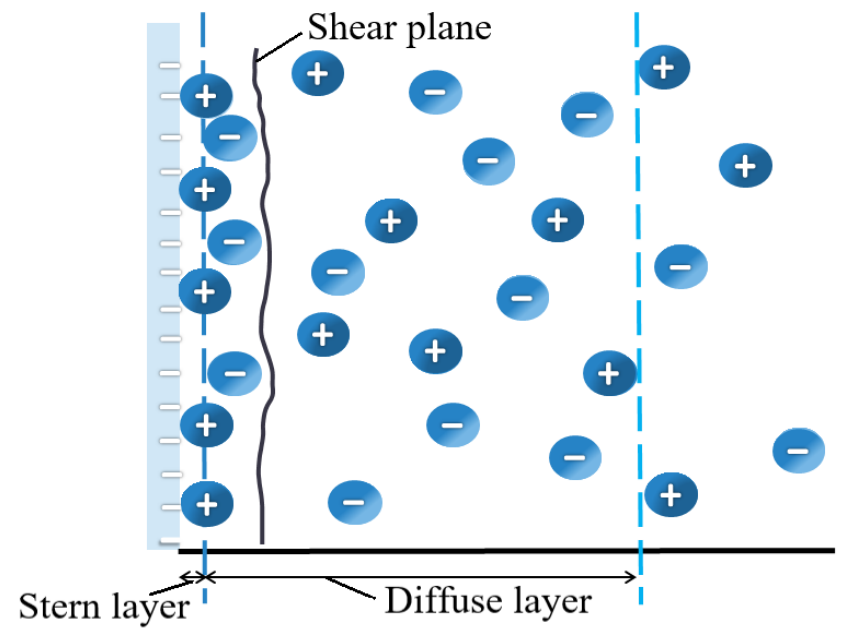
Figure 3. Diagram of electric double-layer structure.